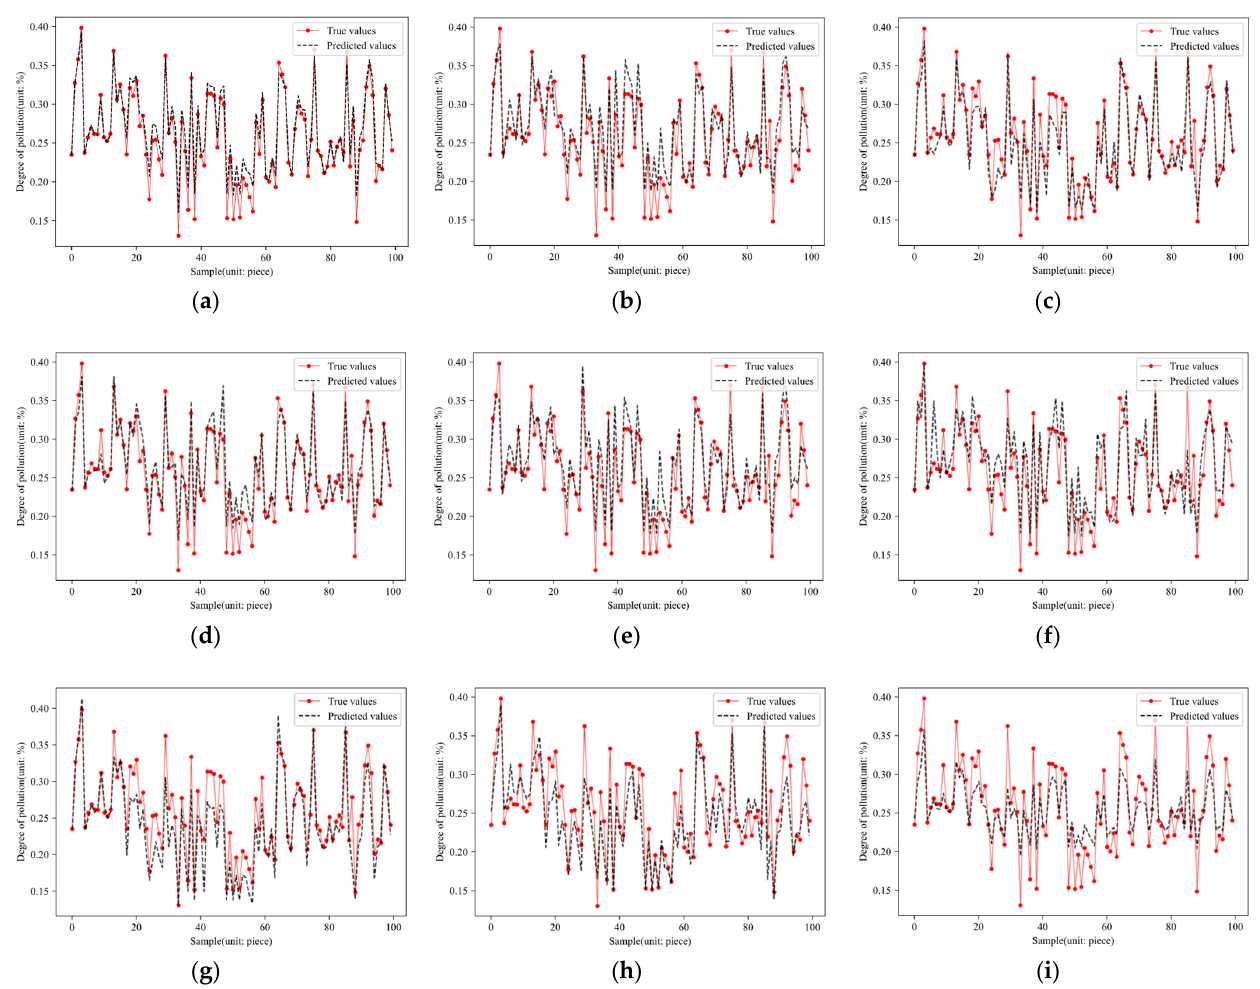
Figure 4. Comparison curves for each model: ( a ) Combined hazard risk values and BXGB-BLGB- GLSTM model predictions; ( b ) Combined hazard risk values and XGB-LGB model predictions; ( c ) Combined hazard risk values and XGB-LSTM model predictions; ( d ) Combined hazard risk values and XGB-LSTM model predictions; ( e ) Combined hazard risk values and XGBoost model predictions; ( f ) Combined hazard risk values and LightGBM model predictions; ( g ) Combined hazard risk values and LSTM model predictions; ( h ) Combined hazard risk values and BP model predictions; ( i ) Combined hazard risk values and SVM model predictions .